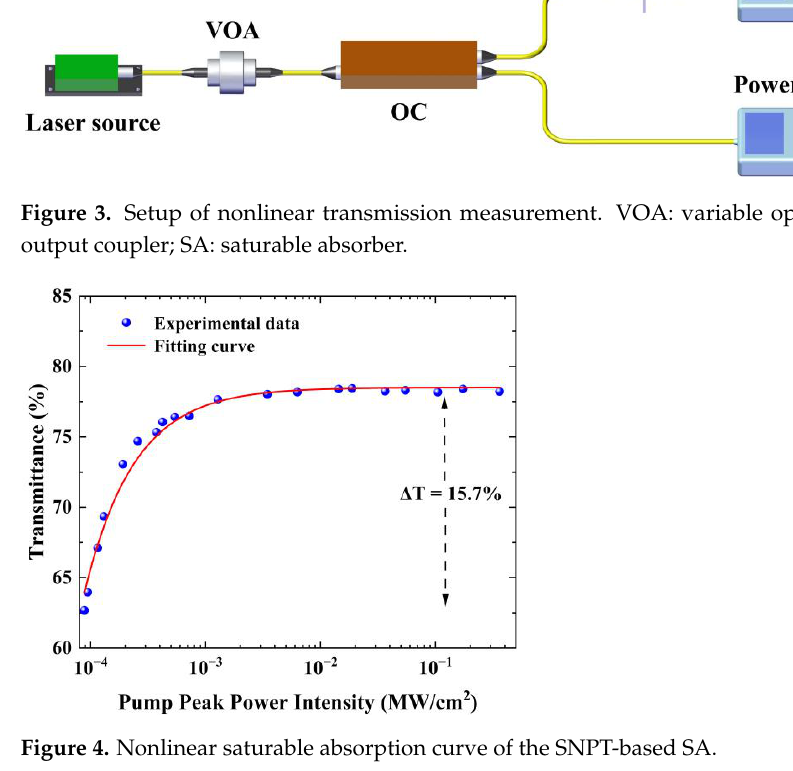
Figure 5. Setup of passively Q-switched fiber laser based on an SNPT-based SA. EDF: erbium-doped fiber; LD: laser diode; WDM: wavelength-division multiplexer; PC: polarization controller; SNPT: silver nanoplate; SA: saturable absorber; PI-ISO: polarization-insensitive isolator; OC: output cou- pler. The output parameters were monitored through an optical spectrum analyzer (Yoko- gawa AQ6375B, Musashino, Japan), a digital storage oscilloscope (Siglent SDS6104 H10 Pro, Shenzhen, China), a spectrum analyzer (Agilent N9320B), and an optical power meter (EXFO FPM-602X, Quebec, QC, Canada). 4. Results and Discussion Originally, the continuous wave operation was first obtained at the pump power of 55 mW. The Q-switched pulses were obtained when the pump power reached 135 mW. Figure 6a shows the optical spectrum at the central wavelength of 1563.3 nm with a full width at half maximum of 0.3 nm. The Q-switched pulse train with a time interval of 16 μs is shown in Figure 6b, in line with the repetition rate of 62.4 kHz (Figure 6d). As shown